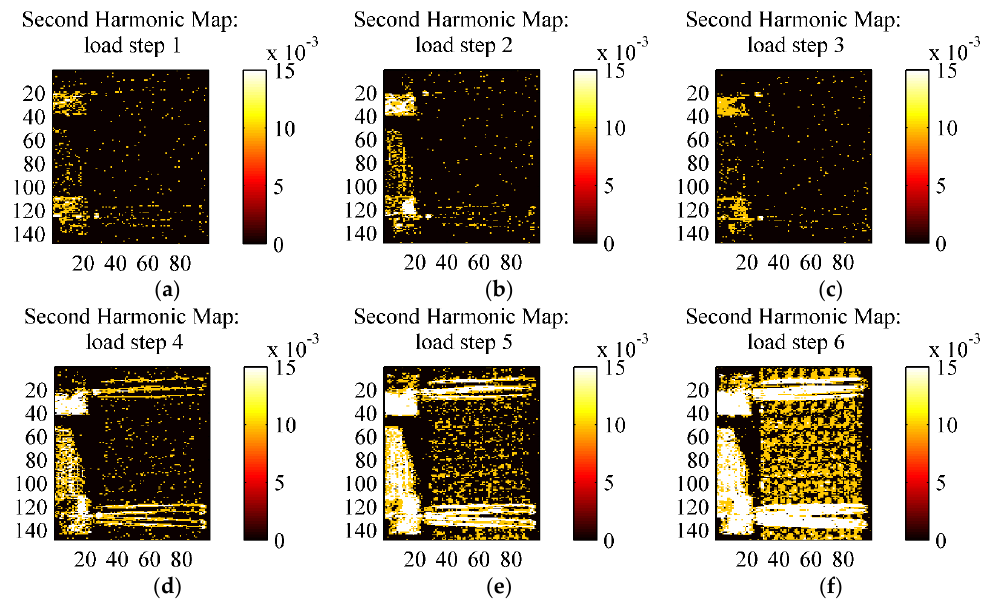
Figure 15. Full field second harmonic signal amplitude in (°C) from an HL sample at the various loading steps. ( a ) load step 1; ( b ) load step 2; ( c ) load step 3; ( d ) load step 4; ( e ) load step 5; ( f ) load step 6.